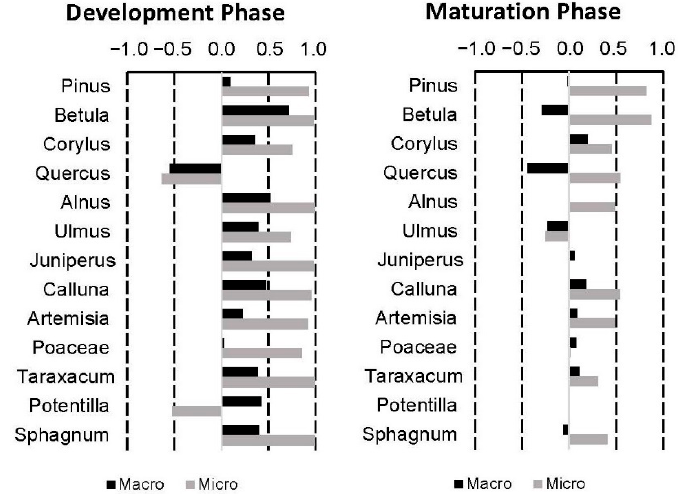
Figure 9. Statistical relationship between the abundance of pollen taxa and macro-/microcharcoal fragment frequency during the development (left panel) and maturation (right panel) of the Spur Bog. See Supplementary Table S1 for further details.